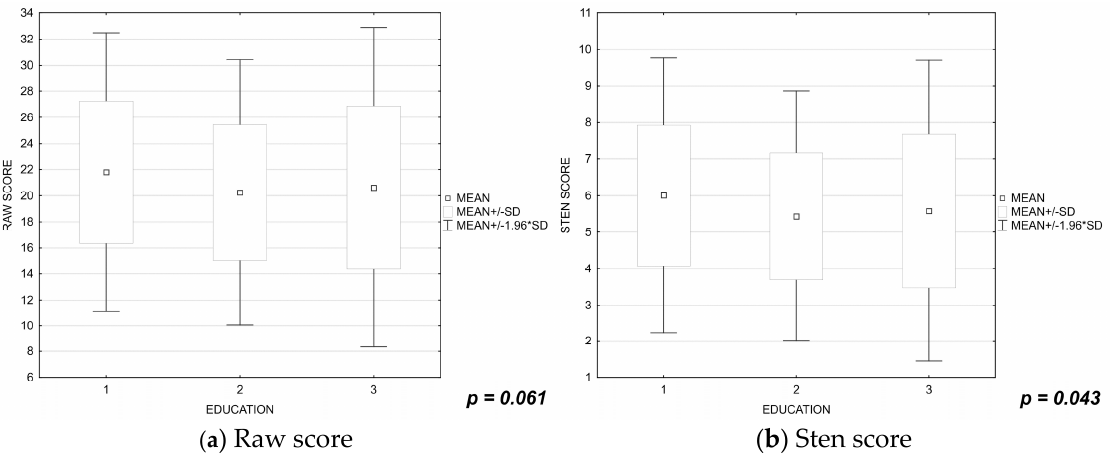
Figure 3. ( a , b ) Influence of the nurses’ levels of education on their satisfaction with life. 1—Master of nursing, 2—Bachelor of nursing, 3—Secondary education in nursing. The nurses whose self-assessed knowledge of SARS-CoV-2 infection was higher felt greater satisfaction with life (raw score: p = 0.008, sten score: p = 0.022; Figure 4a,b).